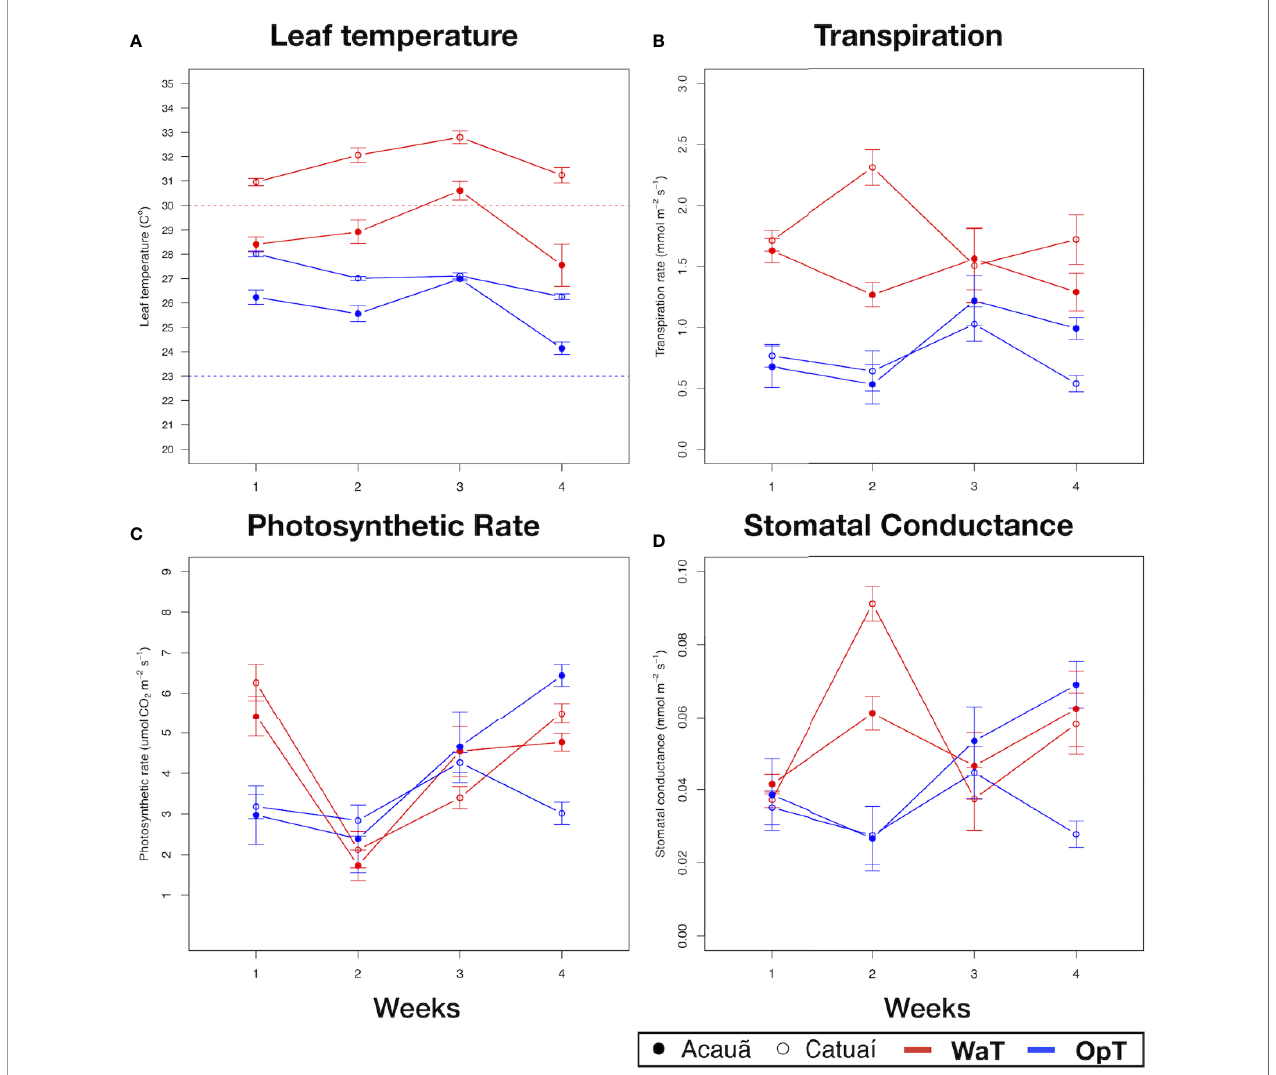
FIGURE 1 | Physiological analysis of two coffee genotypes under optimal and warm temperatures. Physiological parameters of two coffee genotypes, cv. Acauã (closed circles) and cv. Catua ı ́ (open circles), were measured along 4 weeks for each temperature condition, 23/19°C (OpT) and 30/26°C (WaT). (A) Leaf temperature (Tleaf). Dotted lines in the fi gure represent the chamber ambient temperature, OpT (blue dotted line) or WaT (red dotted line), at the time measures were made; (B) transpiration rate; (C) photosynthetic rate; (D) stomatal conductance. Labels: OpT, optimal temperature (23/19°C, day/night); WaT, warm temperature (30/26°C, day/night). Each point represents the mean of 10 plants. Error bars depicts the standard